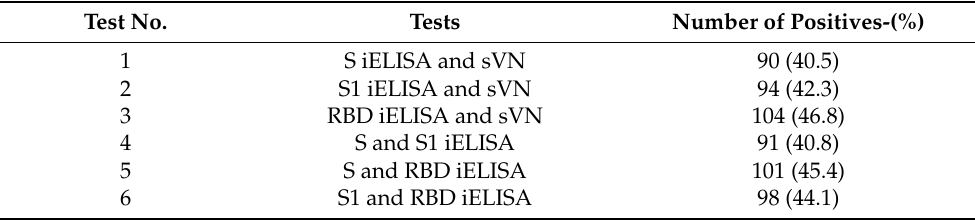
Table 4. Comparison of number of positives in SARS-CoV-2-vaccinated patient sera obtained from iELISAs and sVN tests. 1: Number of sera positive in both S iELISA and sVN tests. 2: Number of sera positive in both S1 iELISA and sVN tests. 3: Number of sera positive in both RBD iELISA and sVN tests. 4: Number of sera positive in both S and S1 iELISA. 5: Number of sera positive in both S and RBD iELISA. 6: Number of sera positive in both S1 and RBD iELISA. Test